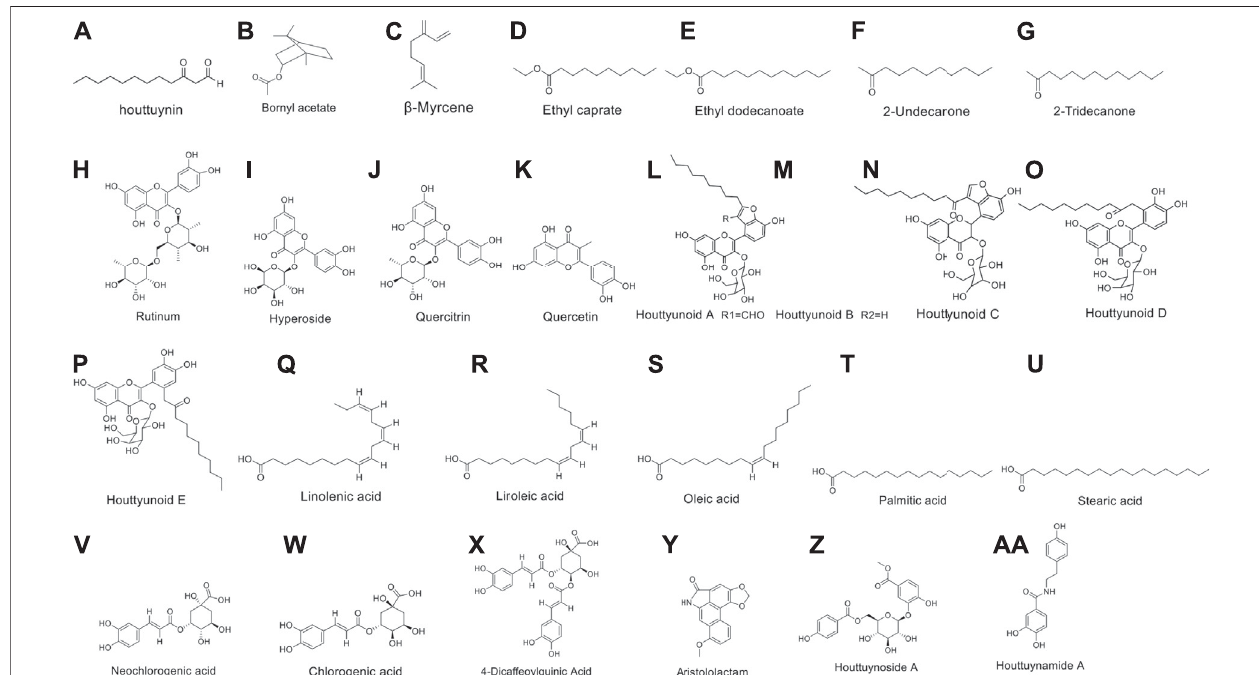
FIGURE 2 | Chemical structures of important constituents of H. cordata